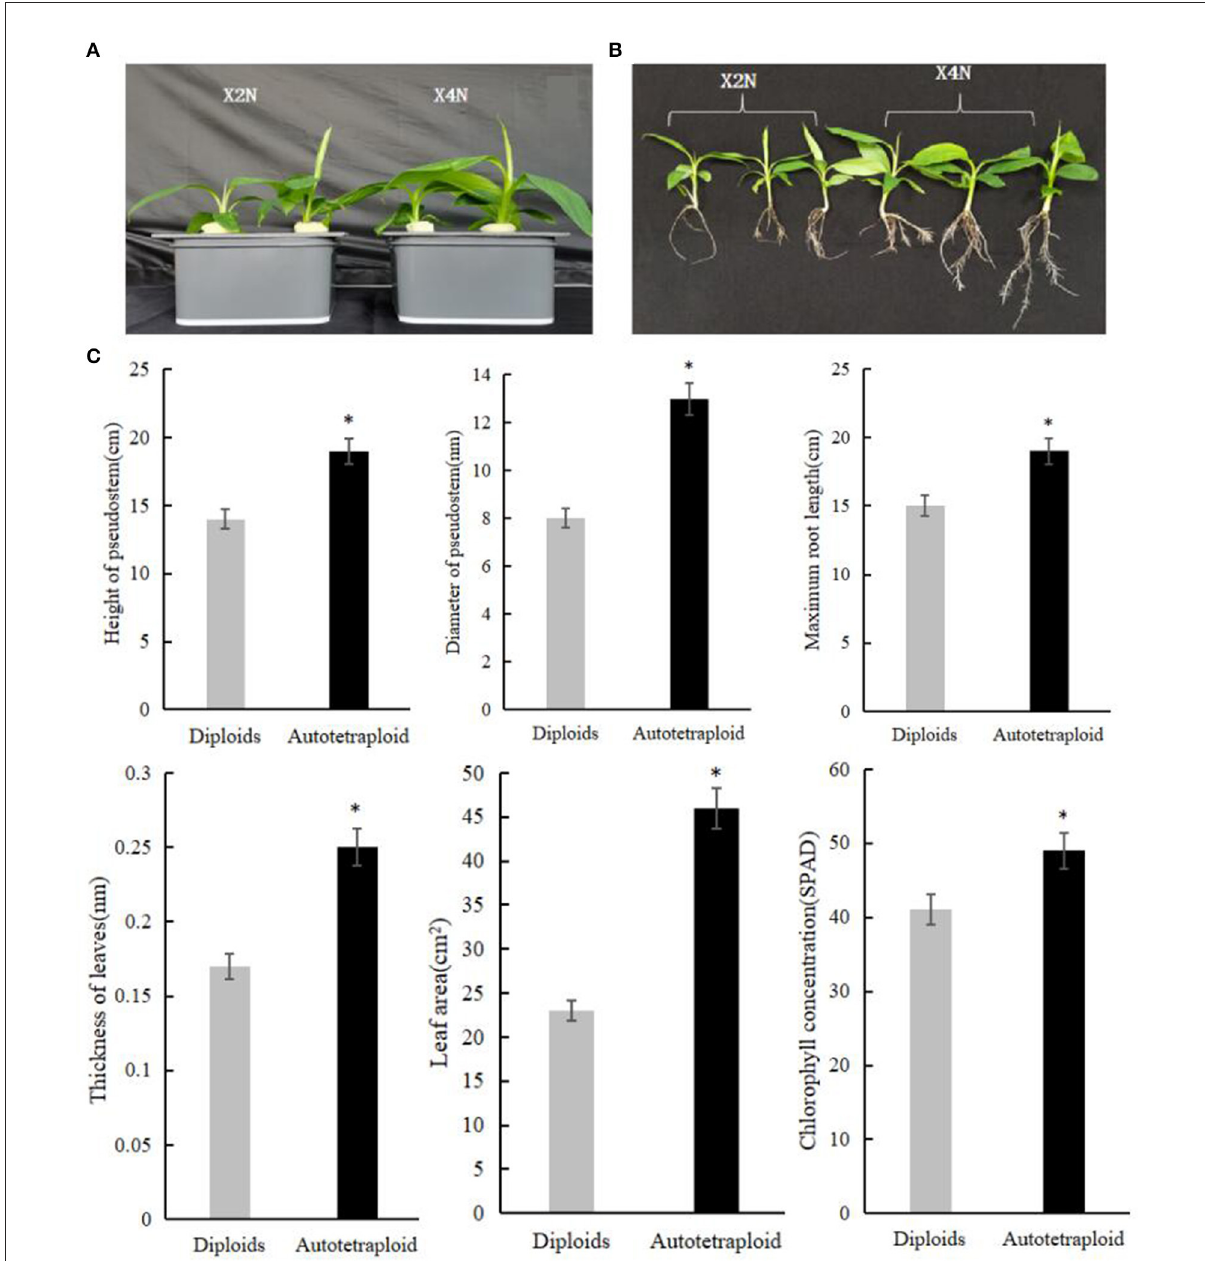
FIGURE2 Phenotypic characterization of autotetraploid and diploid Pisang Berlin seedlings grown under the same conditions. (A, B) Phenotypic comparison of autotetraploid and diploid Pisang Berlin seedlings. (C) The pseudostem diameter, plant height, maximum root length, leaf thickness, leaf area, and chlorophyll content of autotetraploid and diploid Pisang Berlin seedlings. X2N represented diploids of Pisang Berlin. X4N represented autotetraploids of Pisang Berlin. * in the figure represent significant differences at P < 0.05 level.